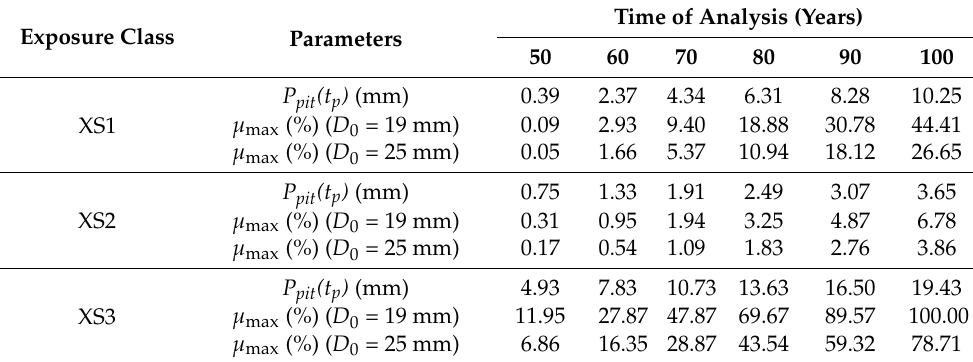
Table 3. Maximum penetration depth and cross-sectional loss over time for the exposure classes